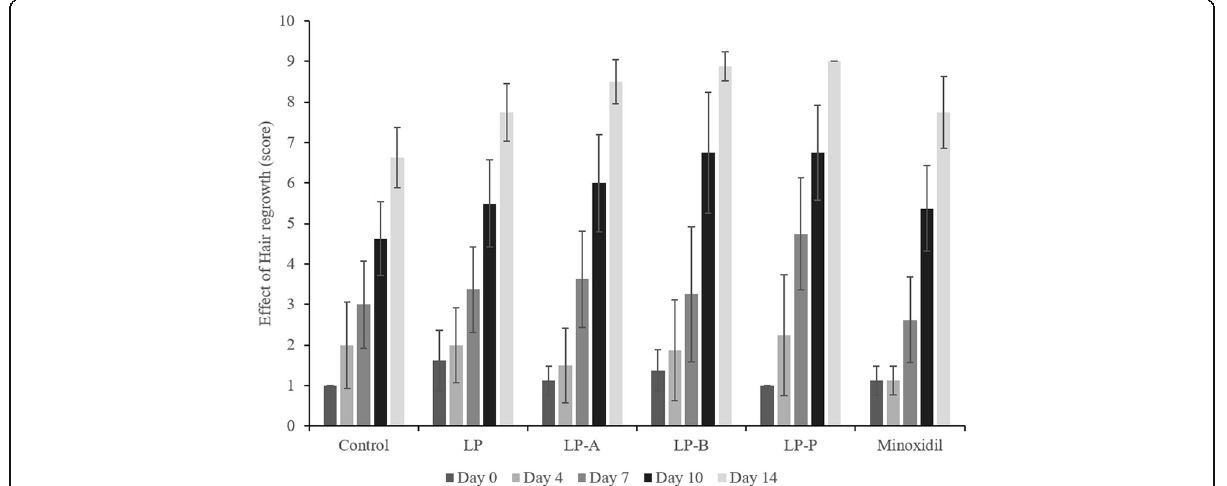
Fig. 5 Hair growth score. Hair regrowth was evaluated inspecting by the gray- or black-colored area (%) on the reverse side of the skin